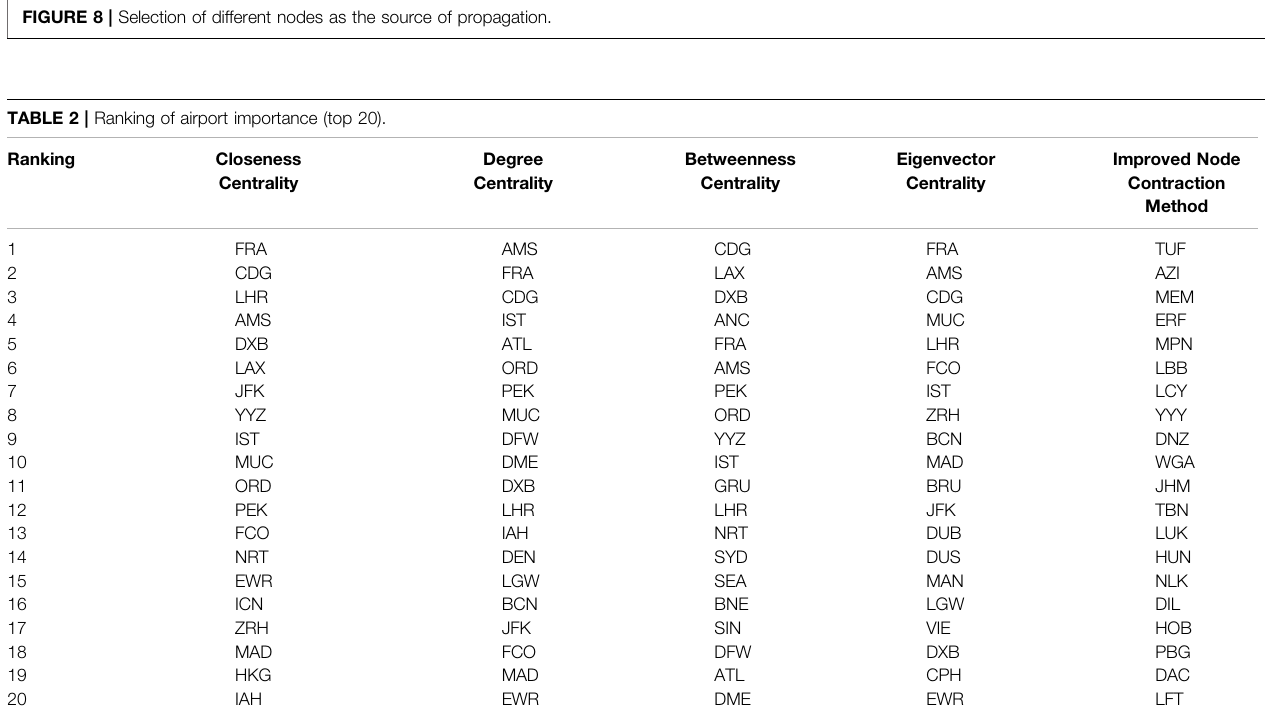
FIGURE 8 | Selection of different nodes as the source of propagation.